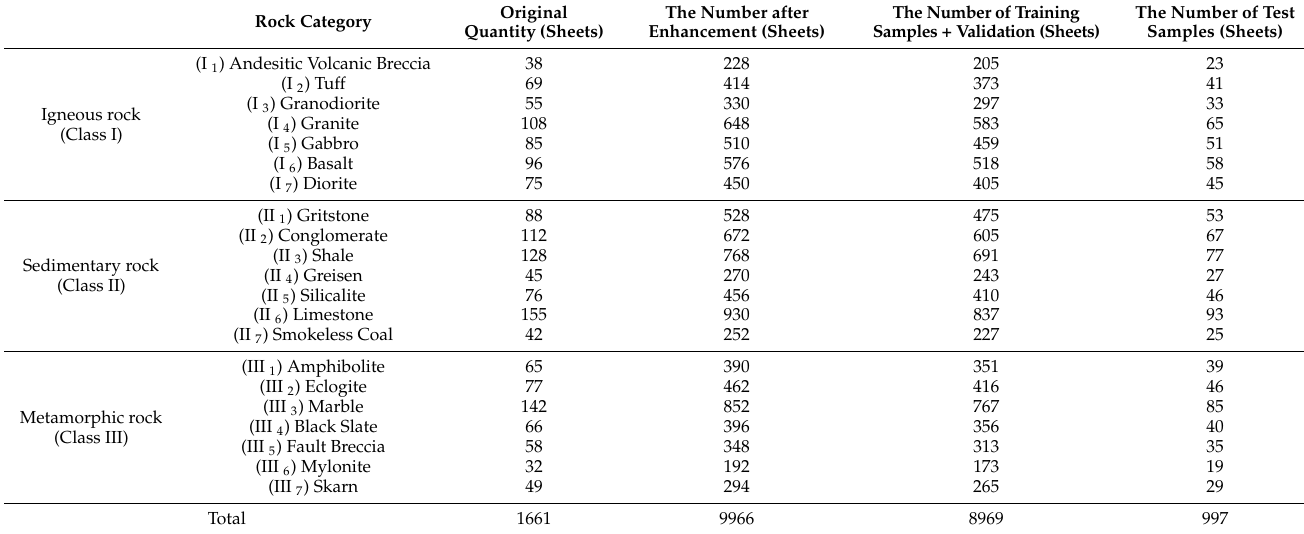
Table 2. Distribution of original number, enhanced number and training test samples of rock